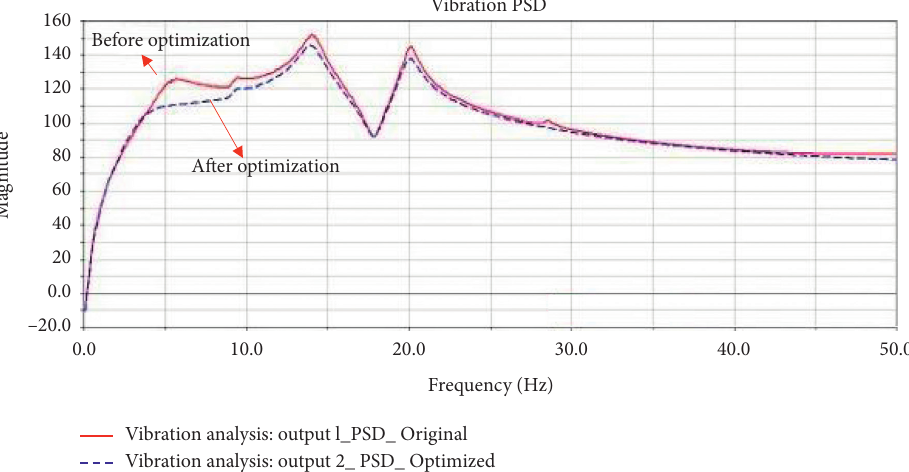
Figure 15: PSD curve of cab centroid acceleration before and after damping optimisation.